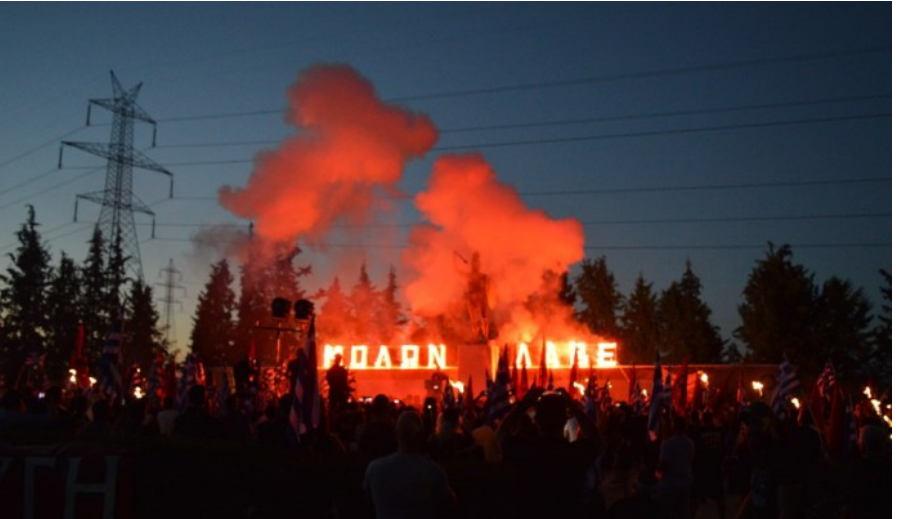
Figure 2. Commemoration event at Thermopylae, organised by the Golden Dawn in 2018. [source: screenshot from YouTube video Θερμοπύλες 2018].